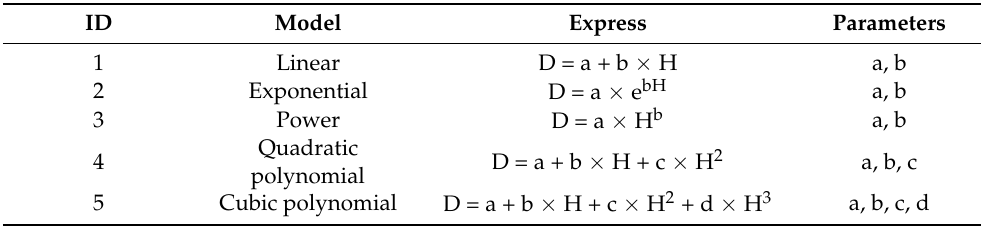
Table 3. Candidate regression models for the relation between the canopy height and the DBH. In the table, D represents the tree DBH (cm), H represents the tree height (m), and a, b, c, and d are constants or parameters.